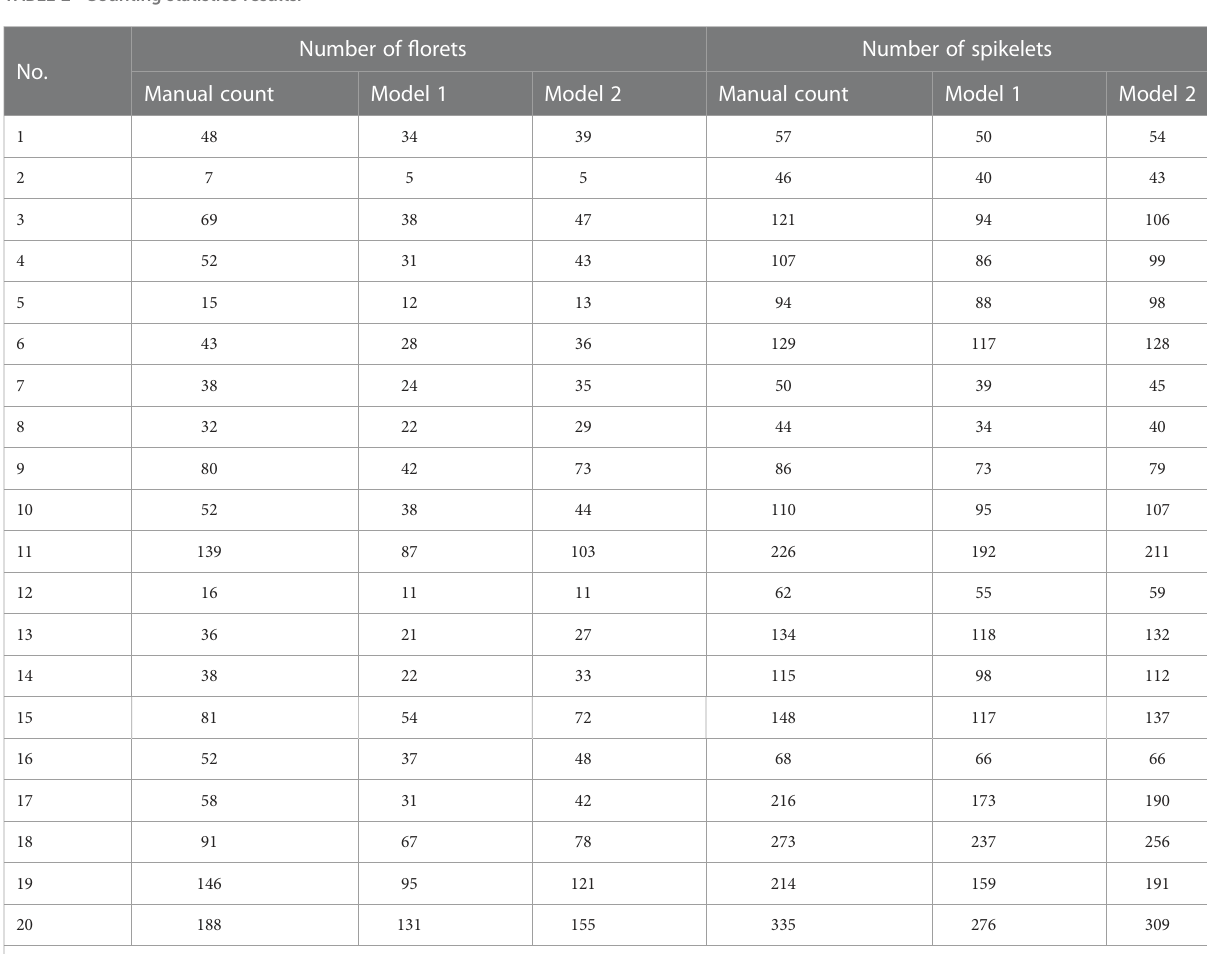
TABLE 2 Counting statistics